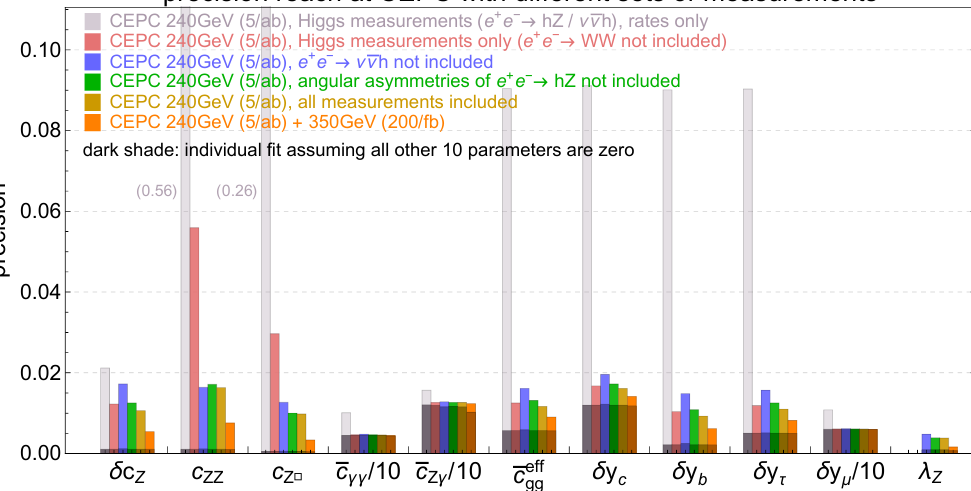
Figure 8 . One-sigma precision reach obtained with various combinations of measurements at the CEPC. The (cid:12)rst (cid:12)ve columns exploit 5 ab (cid:0) 1 of 240 GeV data while the last column also includes 200 fb (cid:0) 1 at 350 GeV. Only Higgs rate measurements ( e + e (cid:22) (cid:23)h ) are included in the (cid:12)rst (cid:0) ! hZ=(cid:23) column. One single measurement is excluded at the time in the three subsequent columns: e + e (cid:0) ! WW in the second, e + e (cid:0) (cid:23) (cid:22) (cid:23)h in the third, and the angular asymmetries of e + e (cid:0) hZ in ! ! the fourth. Note that (cid:21) Z is left unconstrained by Higgs data. All measurements at 240 GeV are included to obtain the constraints in the (cid:12)fth column. A run at 350 GeV is also included in the last, sixth, column. The dark shades correspond to the constraints obtained when one single parameter is kept at the time, assuming all other